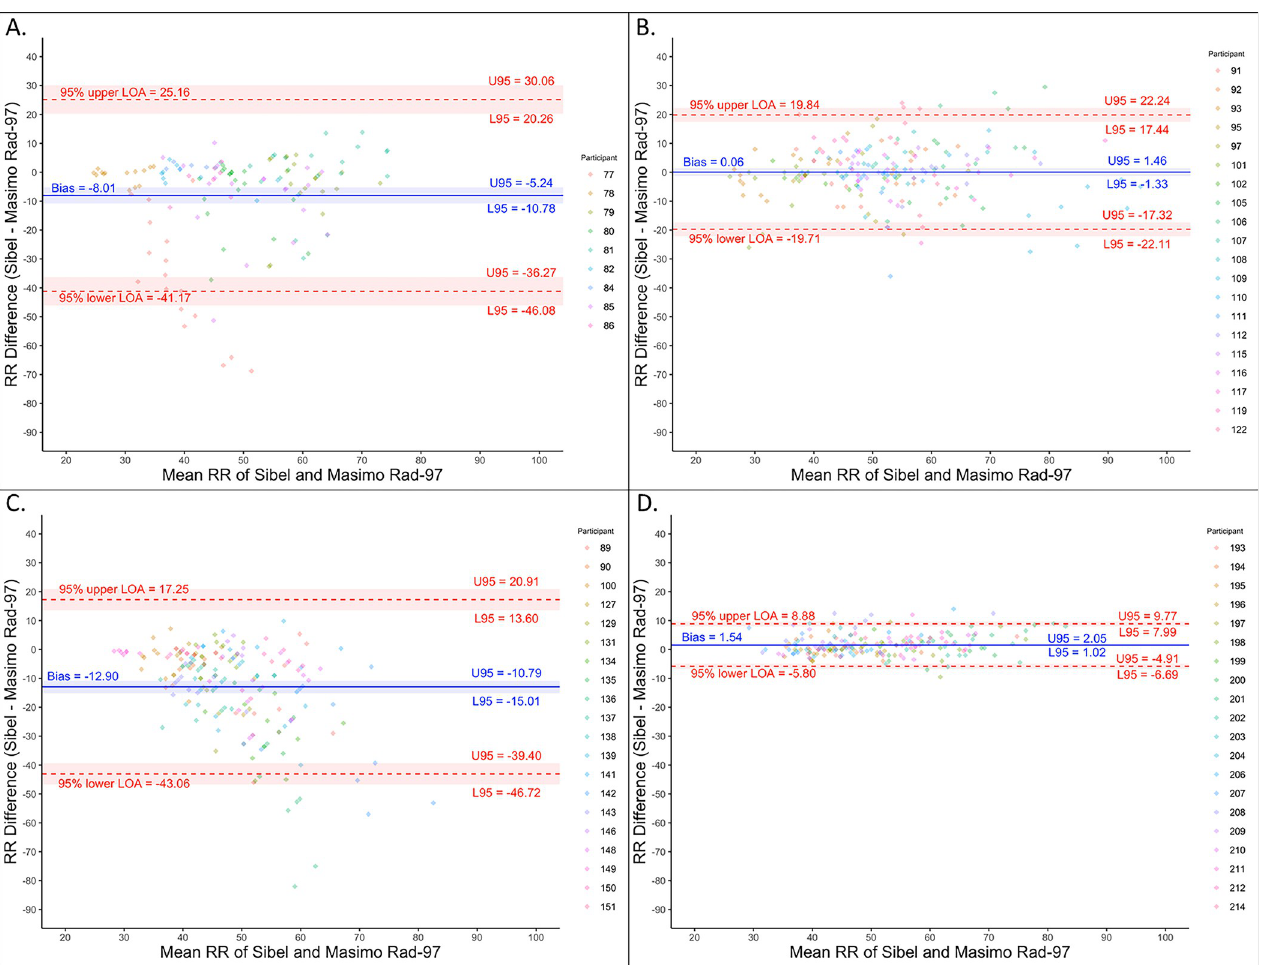
Fig 3. Bland-Altman plots for Rad-97 respiratory rate (RR) median. (A) Open-label round. (B) Closed-label round one. (C) Closed-label round two. (D) Closed-label round three. Colors indicate which enrolled neonate is associated with the measurement